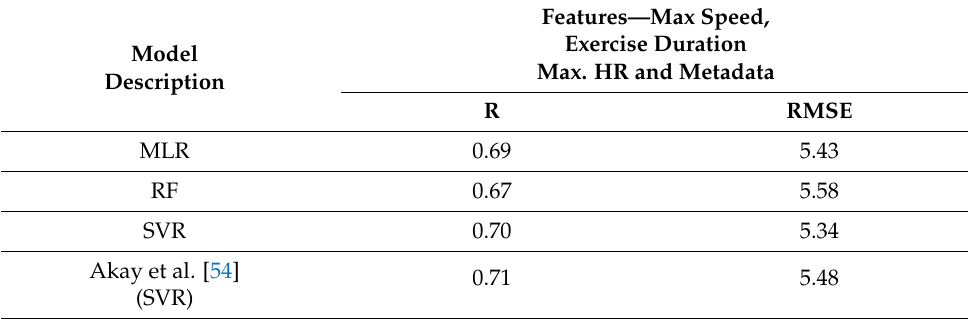
Table 4. Performance Metrics of models with Base